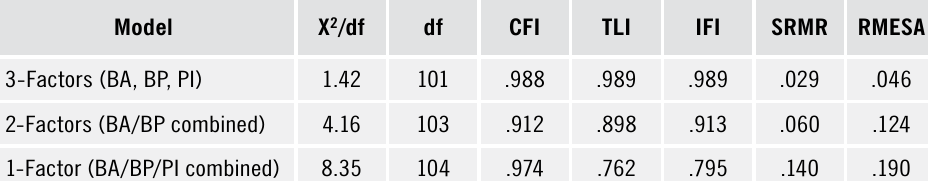
Table 3. Model comparison: discriminant validity